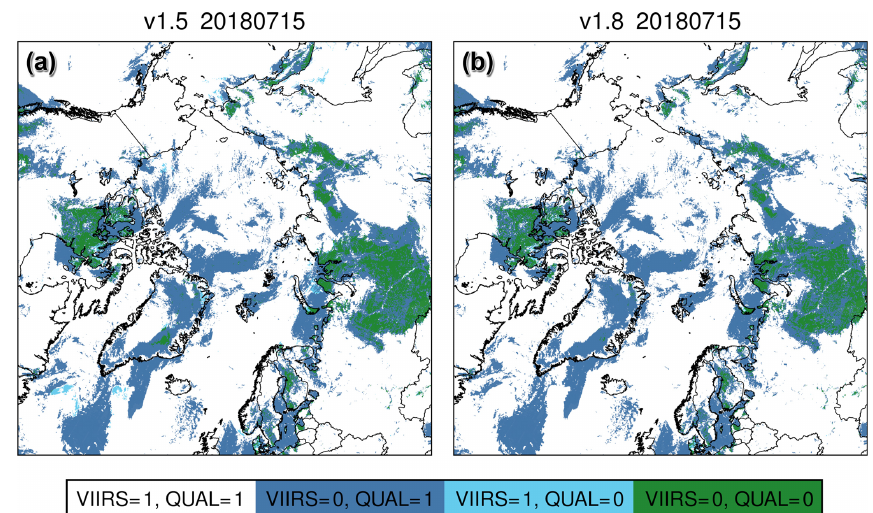
Figure 9. Comparison of the implemented quality filter (QUAL, 1: excluded) with the VIIRS cloud classification (1: cloudy) over the Arctic for (a) v1.5 and (b) v1.8. Matching classifications are shown in white and green. The quality filter is generally stricter than the VIIRS cloud flag (additionally excluded scenes in blue), e.g. for measurements with extremely low albedo such as ocean scenes beyond sun glint. The rare instances of measurements classified as cloudy by VIIRS but still passing the quality filter (cyan) over the Arctic ocean in v1.5 virtually disappear in v1.8.